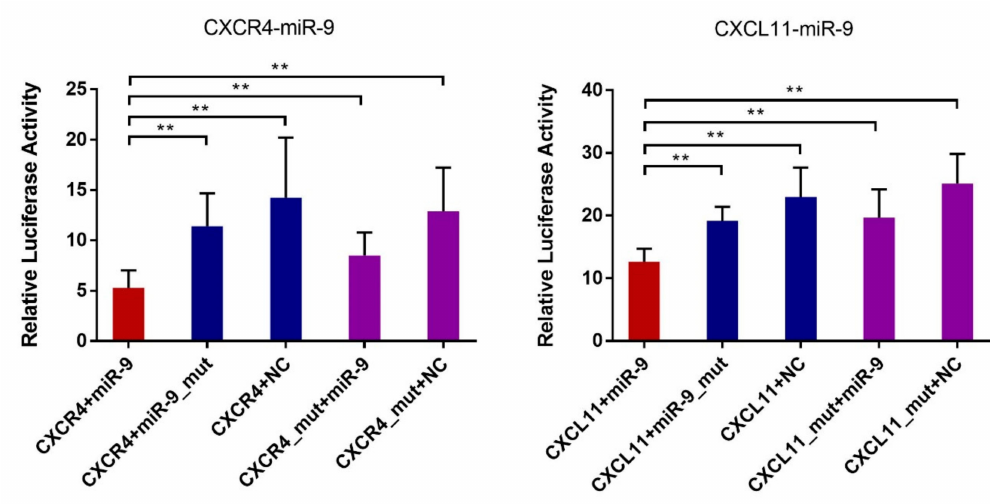
Figure 8. Validation of the predicted miRNA-target interactions with the 3 (cid:48) UTR luciferase reporter system. The wild-type 3 (cid:48) UTR reporter plasmids or mutant 3 (cid:48) UTR plasmids were co-transfected into the PK15 cells in combination with the miRNA mimics, scrambled sequence (NC), or mutant miRNA mimics, respectively. The y-axis shows the dual luciferase activity ratio (Renilla / Firefly luciferase). The error bars show the SD. ** p <